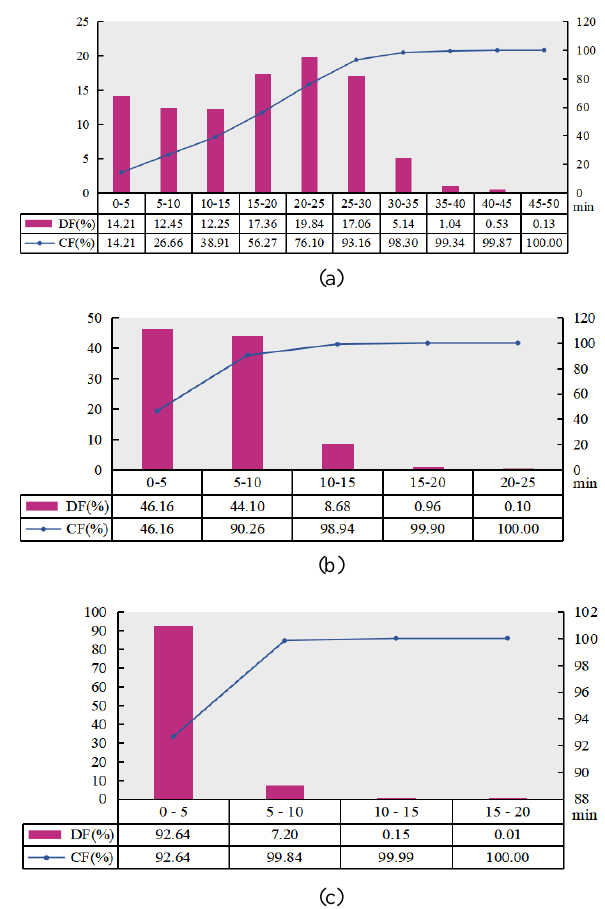
Figure 3. Distribution frequency and cumulative frequency